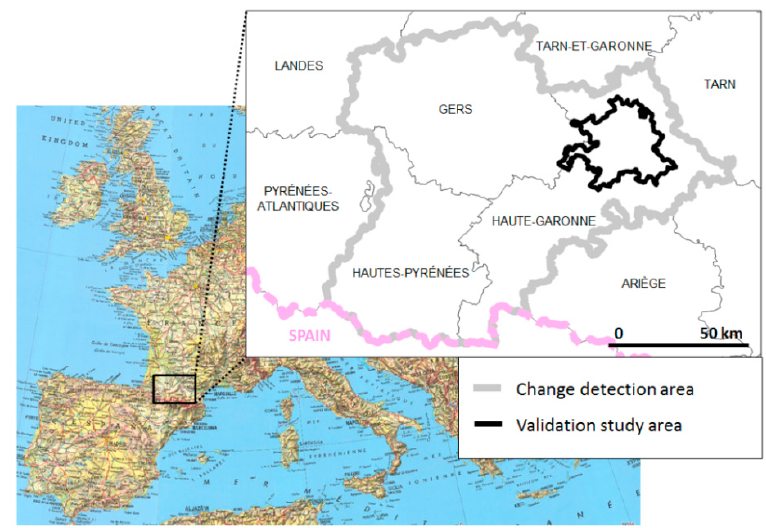
Figure 5. Toulouse and the surrounding pilot study area where the change detection algorithm and validation were applied (Basemap: GEOFLA Geoportal©IGN).